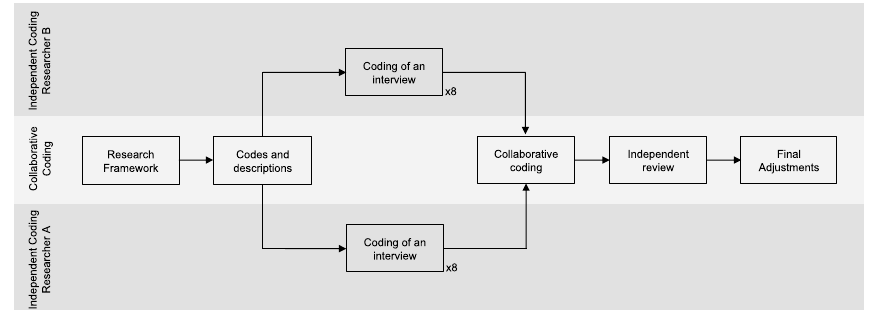
Fig. 2 Representation of the data analysis